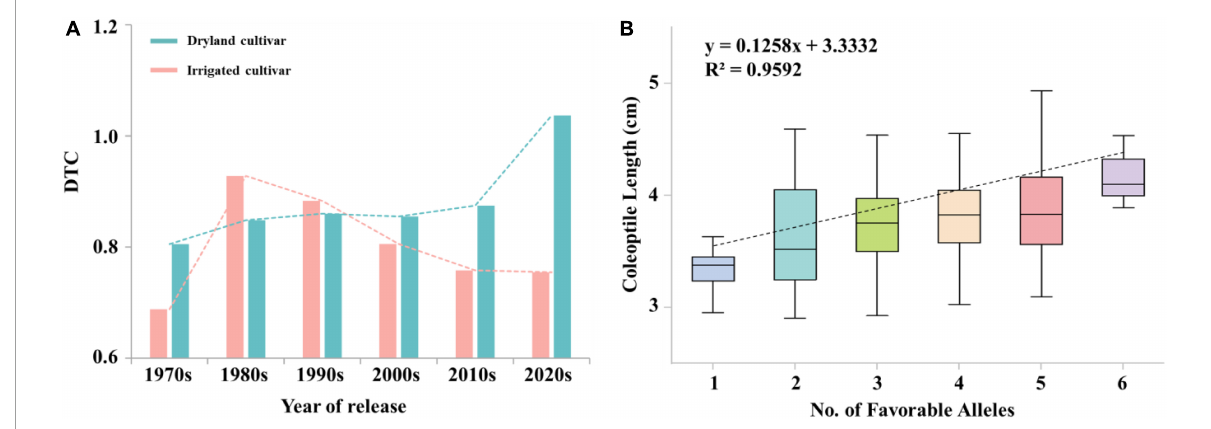
FIGURE5 (A) The trend of DTC values for irrigated cultivars and dryland cultivars over time. (B) Linear regression between the number of favorable alleles in the population and coleoptile length. X and Y in the equation represent the number of favorable alleles and the coleoptile length,